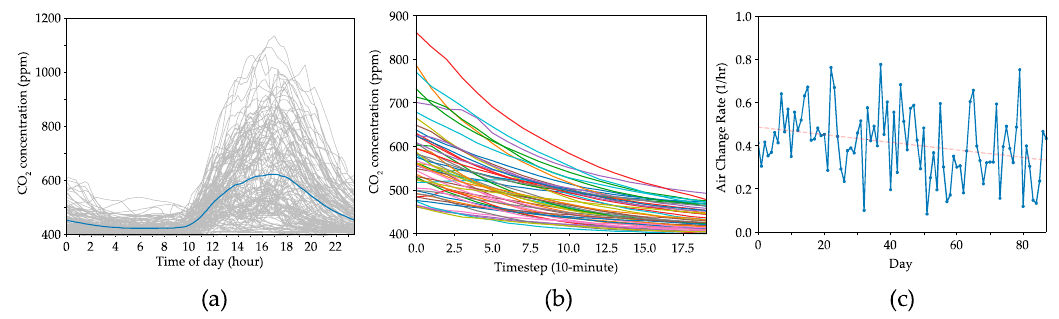
Figure 9. Data from the Elemental platform deployed in an academic lab and office space showing ( a ) daily CO 2 concentrations, ( b ) extracted natural CO 2 decay curves, and ( c ) air change rates calculated from the decay curves each day, plotted versus time.